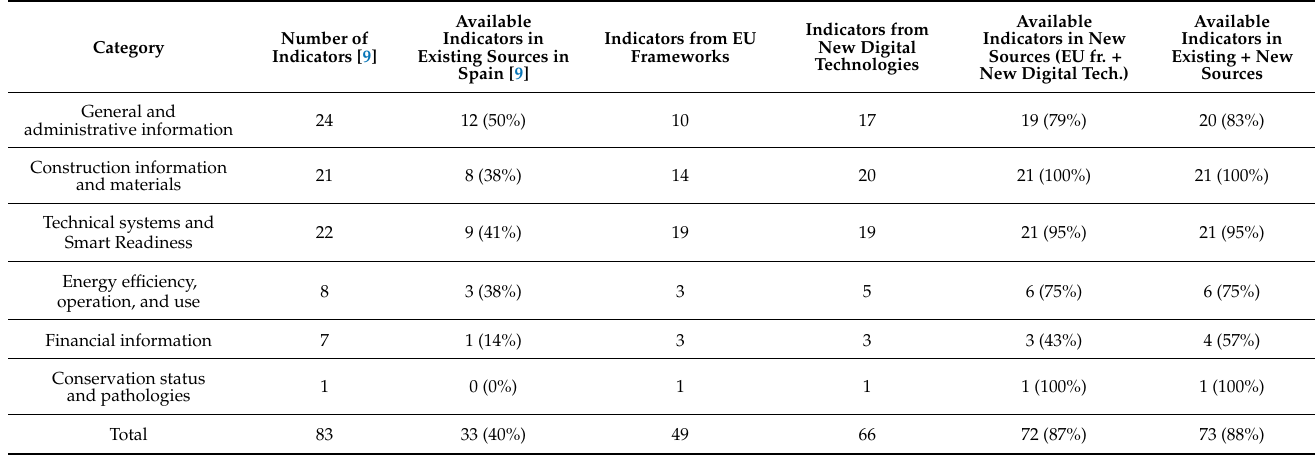
Table 2. Summary of available data in different data